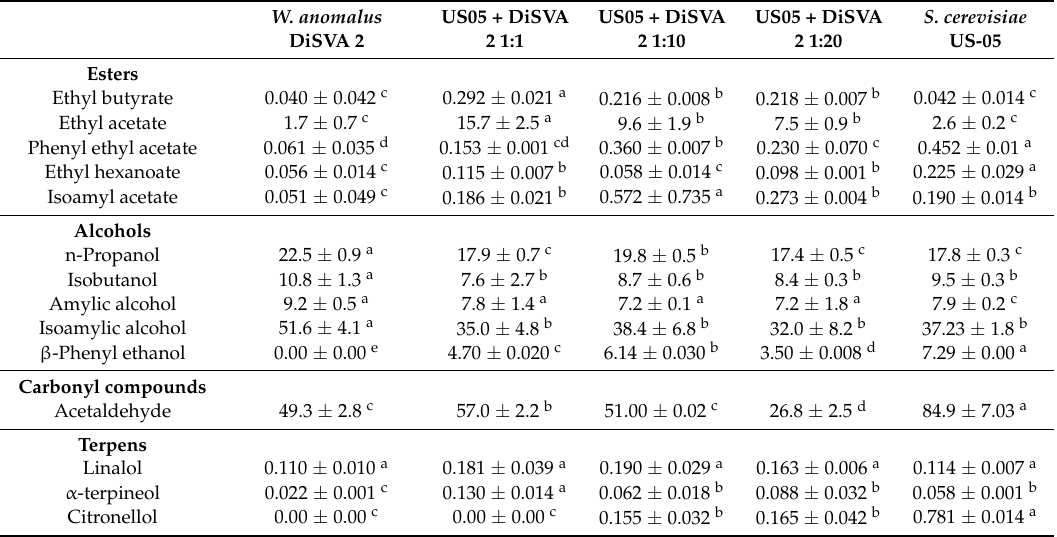
pure and mixed fermentations (mg/L).